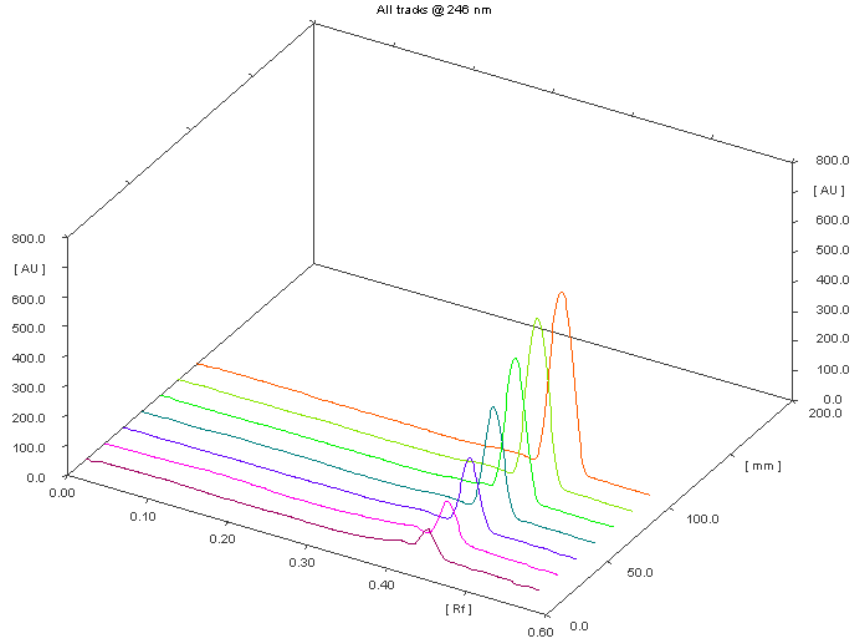
Figure 5. Three dimensions TLC chromatogram showing clobetasol propionate linearity range (0.188 ÷ 5 µ g/spot) at R F = 0.51 ± 0.01. Note: @—at.